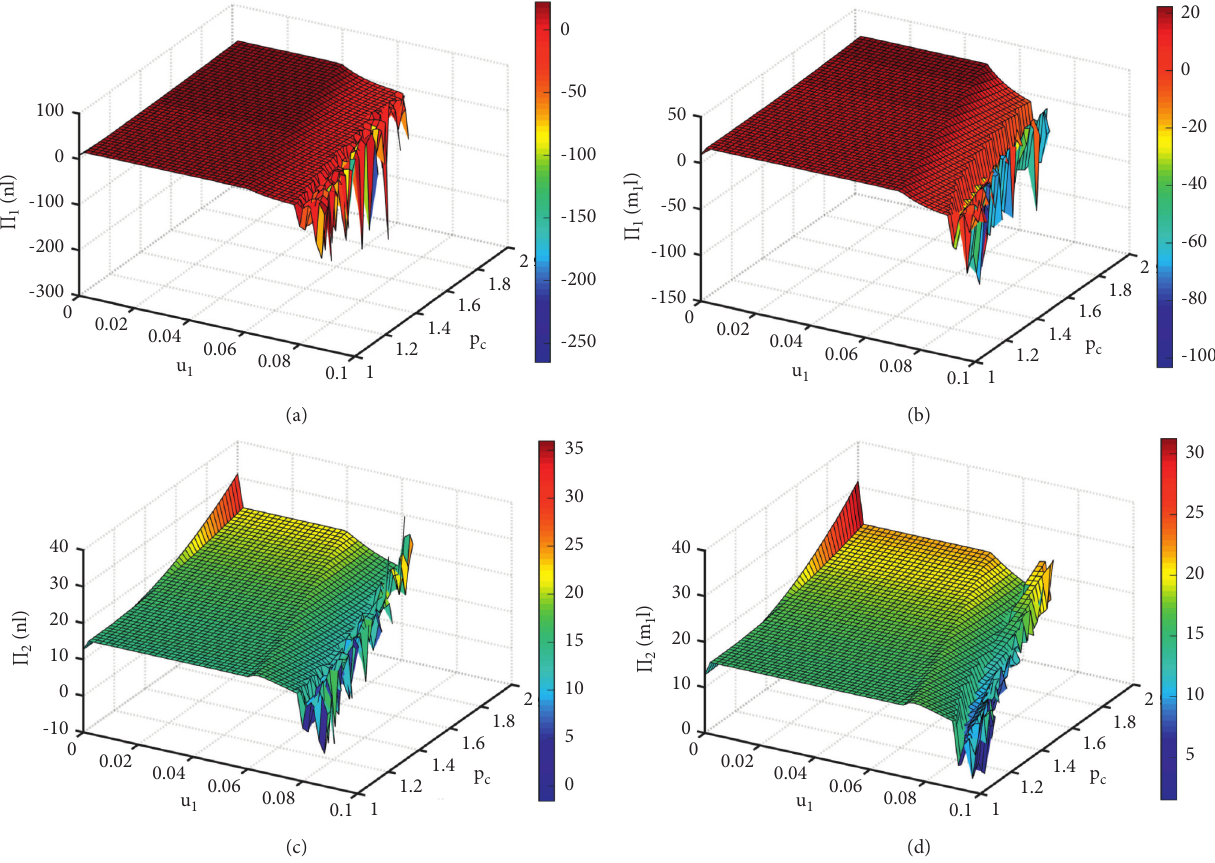
Figure 9: Change of profits with respect to u